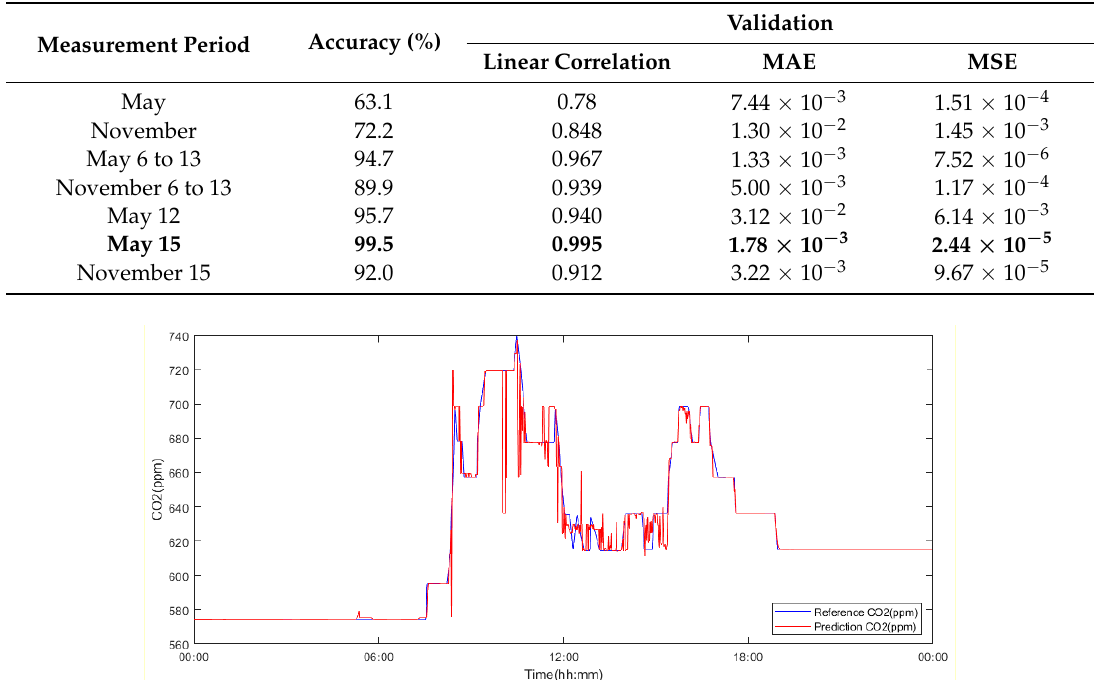
Figure 14. Model number 3 trained and validated using data from the interval of 12 th of May 2018.